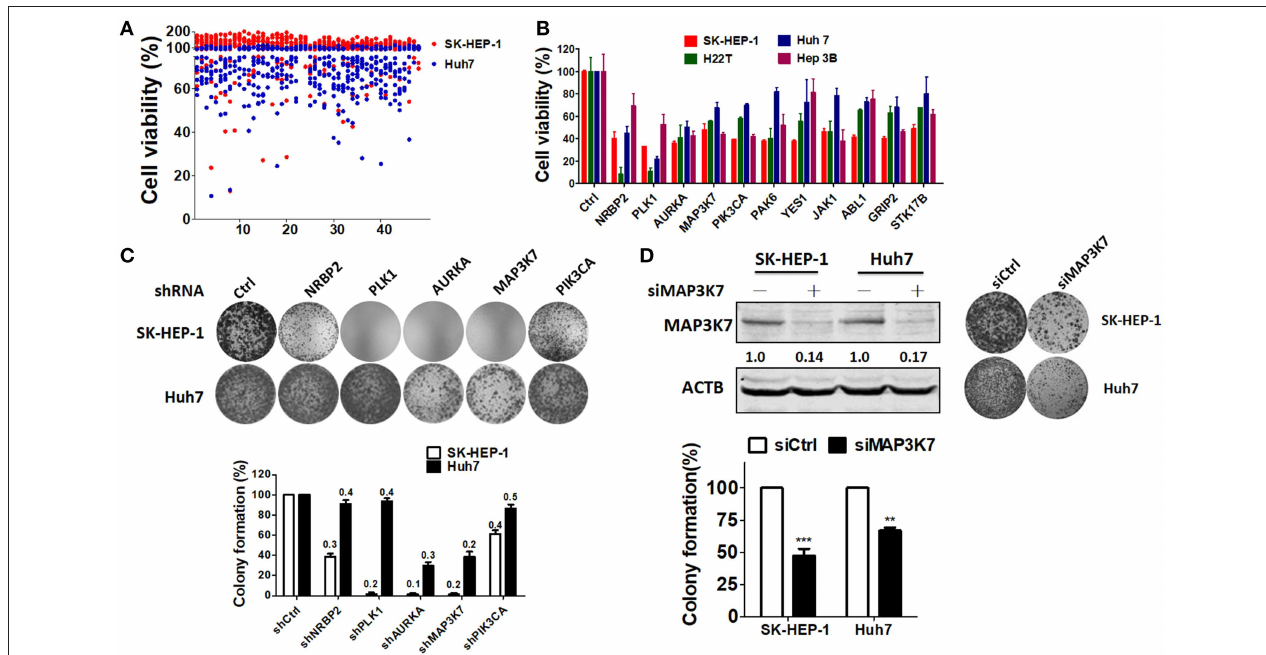
FIGURE 1 | Kinome siRNA library screening for kinases required for HCC cell proliferation. (A) Hep3B and Huh7 cells were seeded in 384-well plates containing the kinome siRNA library (5nM pooled siRNA for each gene) for 72h. Cell proliferation was determined by a CellTiter Glo assay. (B) siRNAs against the top 11 ranked kinase hits were transfected into SK-HEP-1, HA22T, Huh7, and Hep3B cells for confirmation with a cell proliferation assay. (C) Stable knockdown with shRNA against NRBP2, PLK1, AURKA, MAP3K7, or PIK3CA in SK-HEP-1 and Huh7 cells was performed, and their effects were tested with a colony formation assay. Knockdown efficiency was examined by real-time PCR as indicated in each bar. (D) Knockdown efficiency in the MAP3K7 protein level of HCC cells was validated by immunoblotting. Inhibition of cell proliferation by siRNA against MAP3K7 in HCC cells was verified by a colony formation assay and quantified in the lower panel from three independent experiments. ** p < 0.01; *** p <